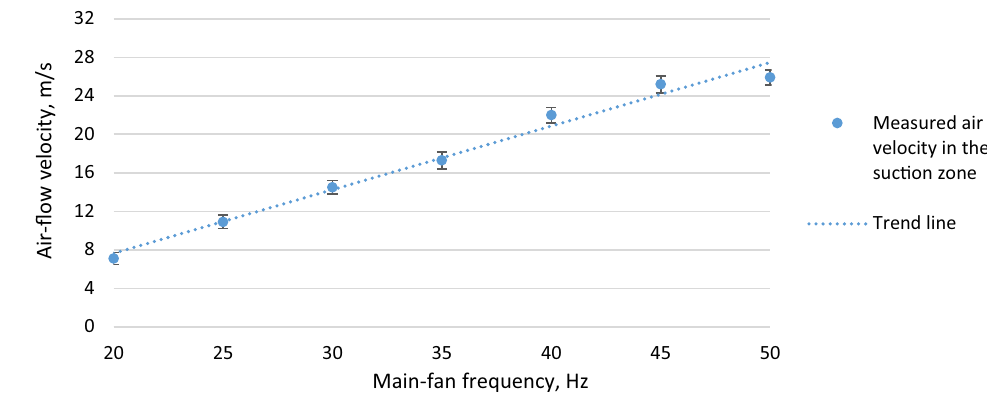
Fig. 8 Measurement results for the air-flow velocity with respect to the main-fan